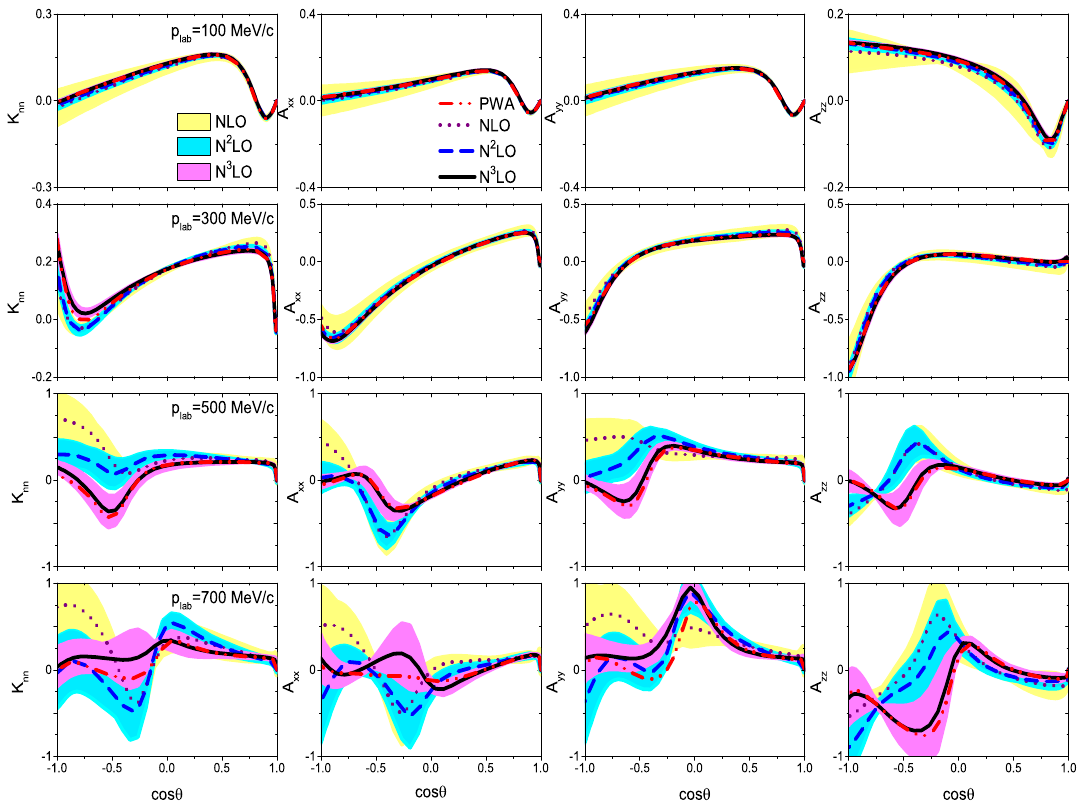
Figure 11 . Spin correlation parameters K nn , A xx , A yy , and A zz for (cid:22) pp elastic scattering. Notations are described in the